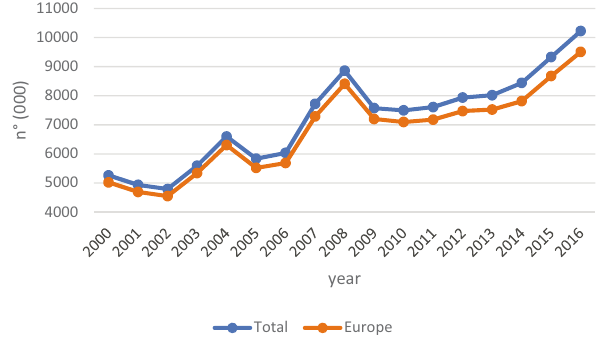
Figure 1: Total tourist arrivals in Romania from all countries for the period 2000 – 2016 ( source: author ’ s own elaboration on data available at http://statistici.insse.ro:8077/tempo - online/#/pages/ tables/insse - table ) .